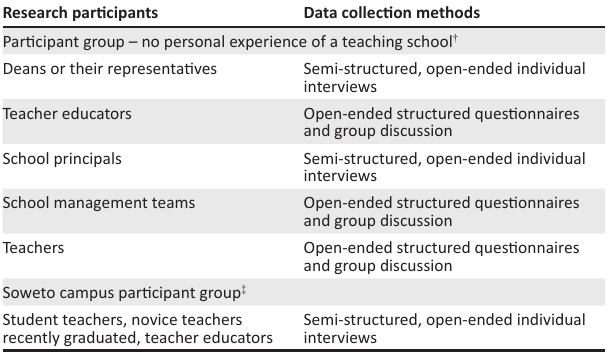
TABLE 1: Summary of data collection process.